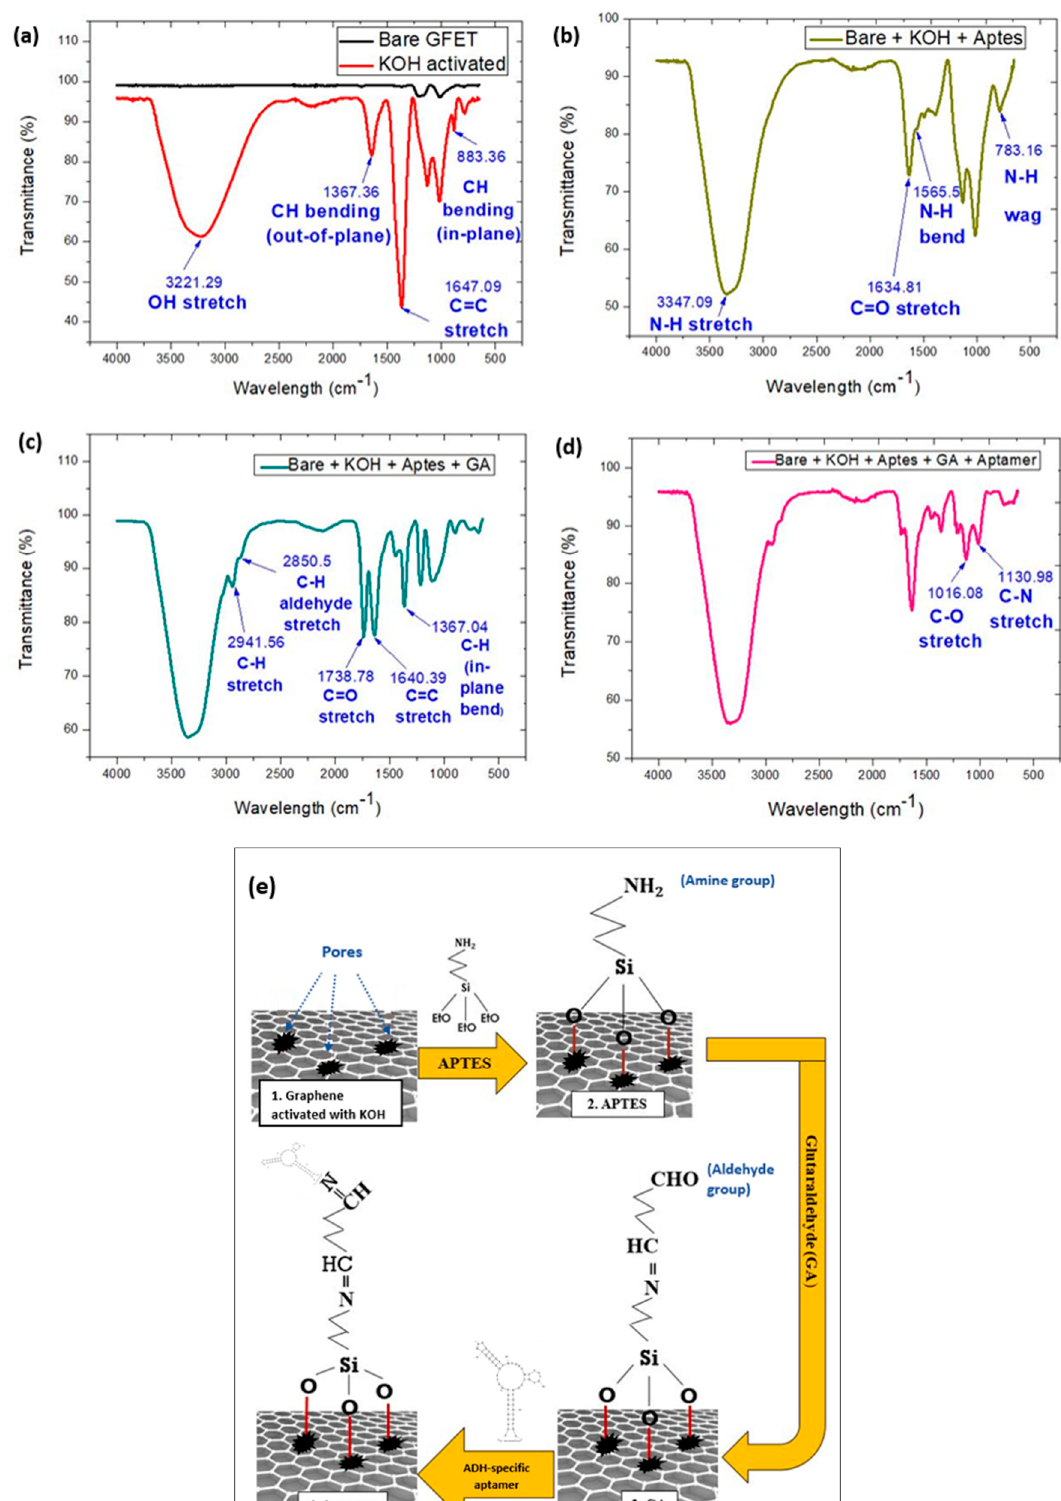
Figure 4. Attenuated total reflectance Fourier transform infrared (ATR-FTIR) spectra for surface functionalization of graphene in GFET. ( a ) KOH activation; ( b ) surface modification with APTES; ( c ) surface modification with glutaraldehyde (GA); ( d ) immobilization with ADH-specific aptamer and ( e ) schematic illustration of all stages in surface functionalization of